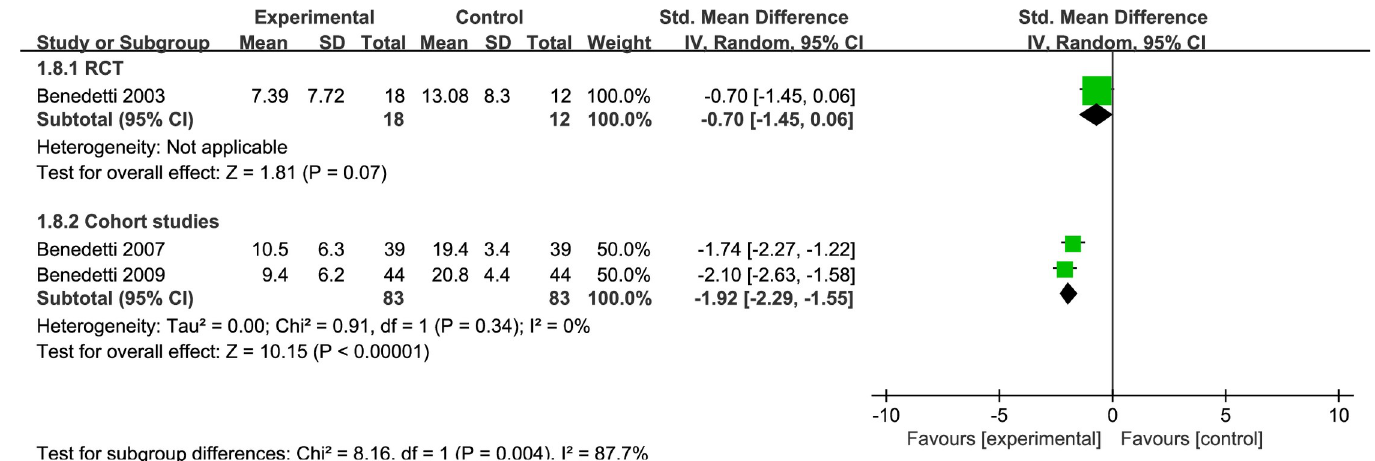
Fig 8. Forest plots for green light therapy.